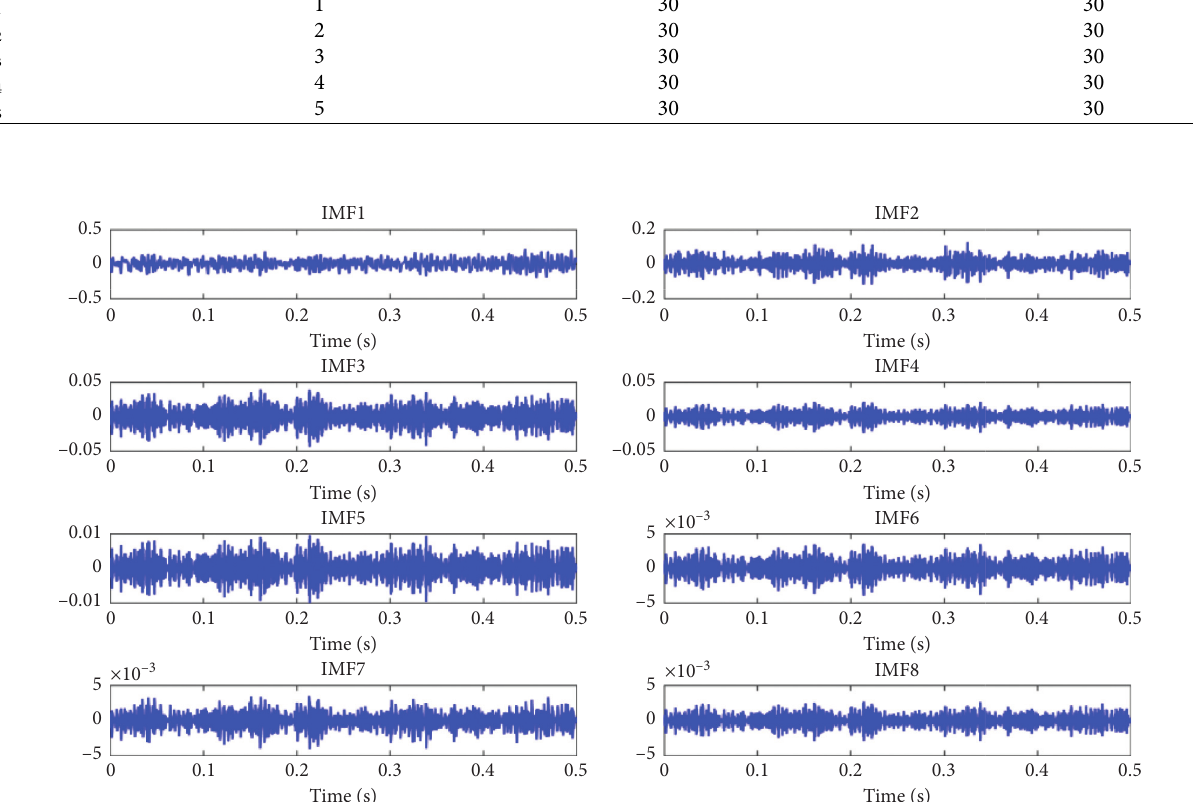
Figure 12: The decomposed IMF components of sound signal based on